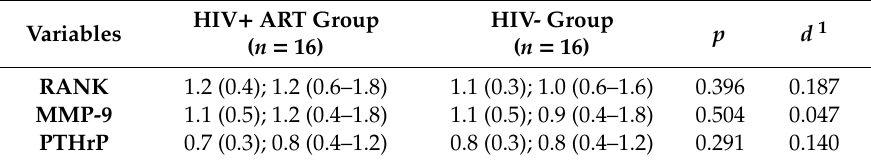
Table 3. Comparison of the expression of the 3 inflammatory markers studied between the PLWHIV and non-HIV infected